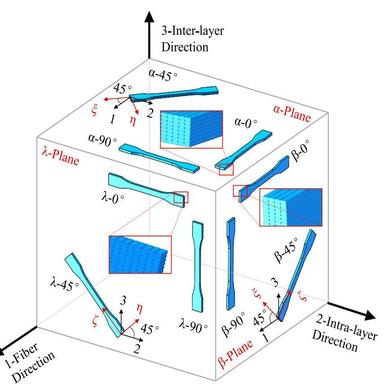
Three different categories of specimens on the α, β, and λ plane.